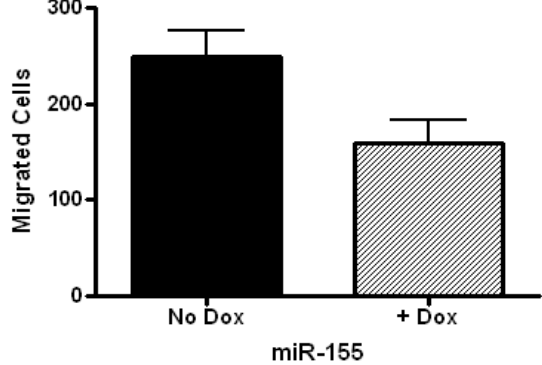
Figure S2. Migration assay of LN229 cells expressing miR-155 under the control of a doxycycline-inducible vector. Expression of miR-155 was induced for 48 h before plating onto 8 µm membranes, as detailed in Experimental